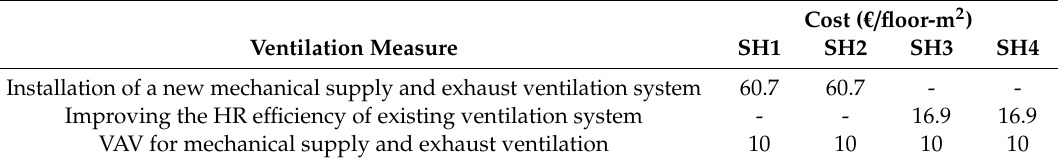
Table 8. Cost of ventilation retrofit. [56] Variable air volume (VAV) can only be used with mechanical supply and exhaust ventilation.